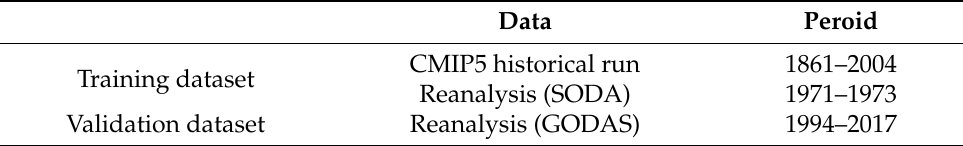
Table 1. The datasets for training and validating the DC-LSTM model.